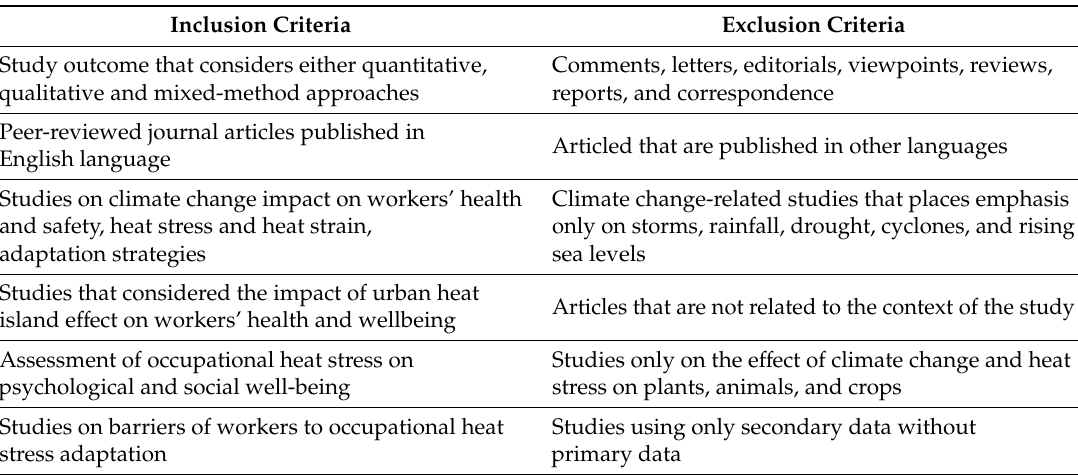
Table 1. Inclusion and exclusion criteria considered in the selection of